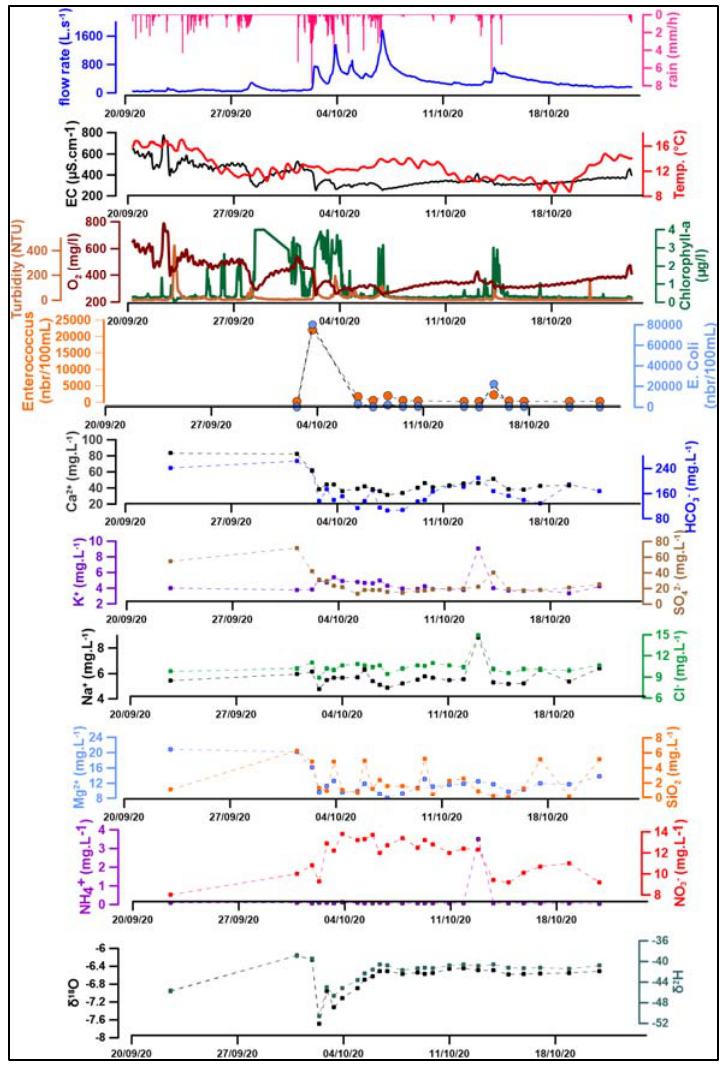
Figure B1. Chemiograph of the Themines sink from 20/09/20 to 21/10/20. Figure A4. Chemiograph of the Themines sink from 20/09/20 to